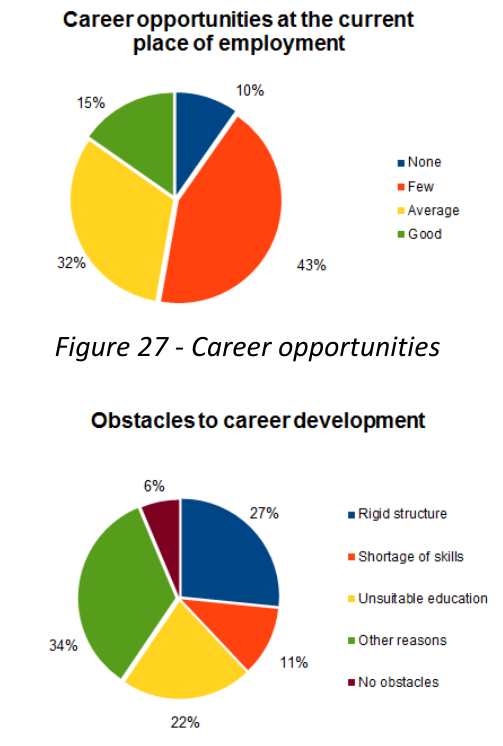
Figure 28 - Obstacles to professional career